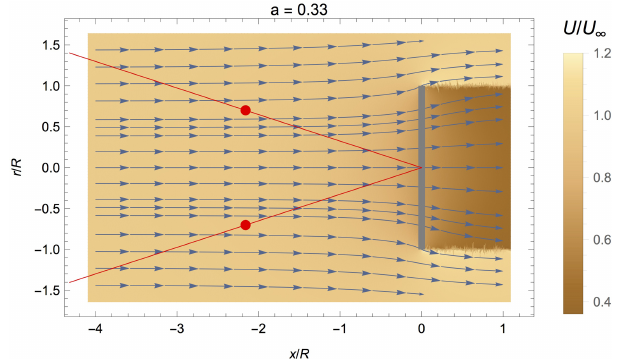
Figure B1. Example of the flow speed reduction and diversion around the rotor of a wind turbine. The red lines indicate the laser beam and the red dots show the focus